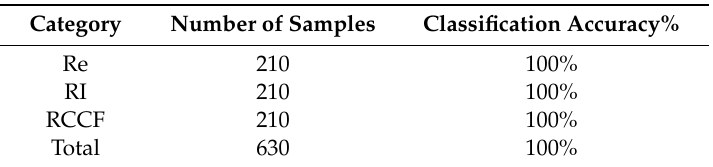
Table 6. Category recognition